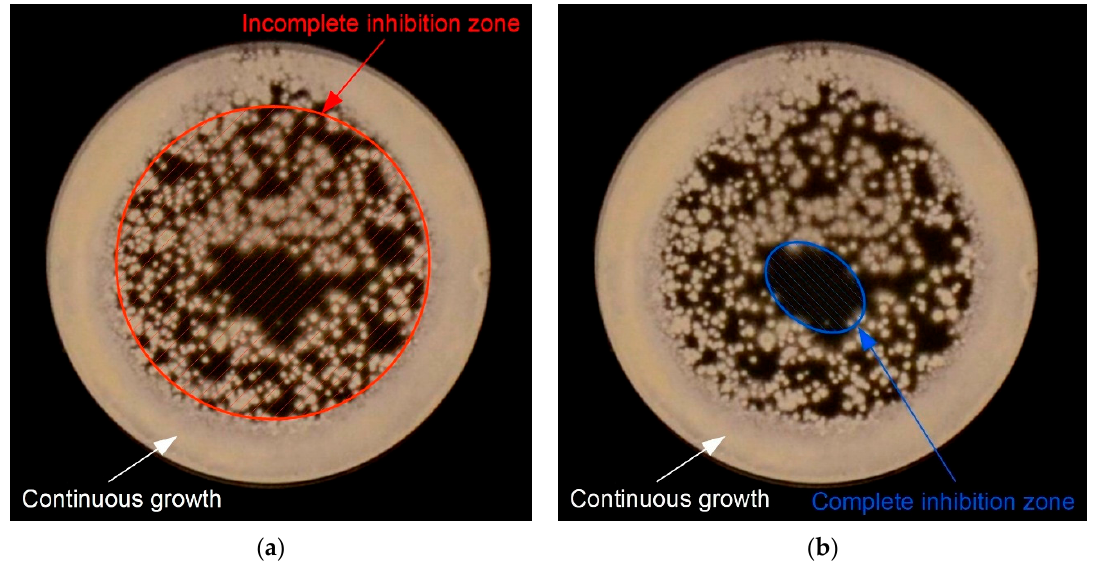
Figure 8. An example of the determination of inhibition zones for the evaluation of the microbicidal properties: ( a ) determination of an incomplete inhibition zone; ( b ) determination of a complete inhibition zone.